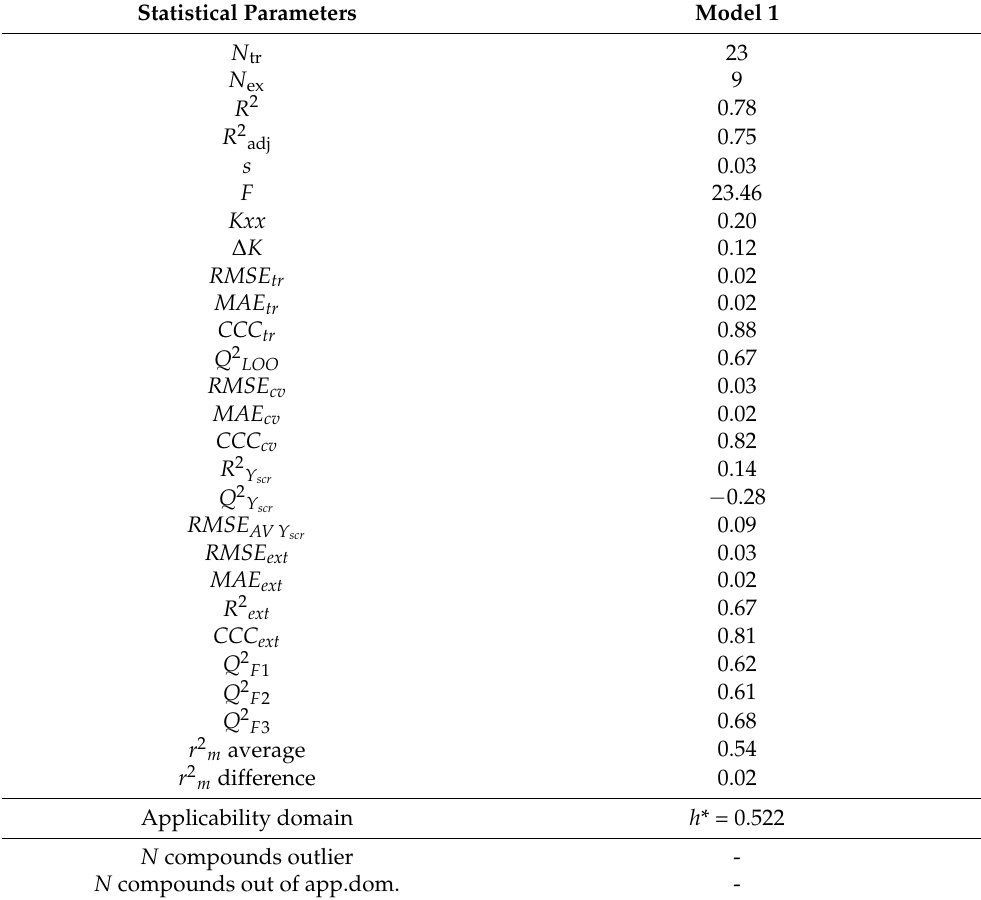
Table 4. The statistical results of QSAR models